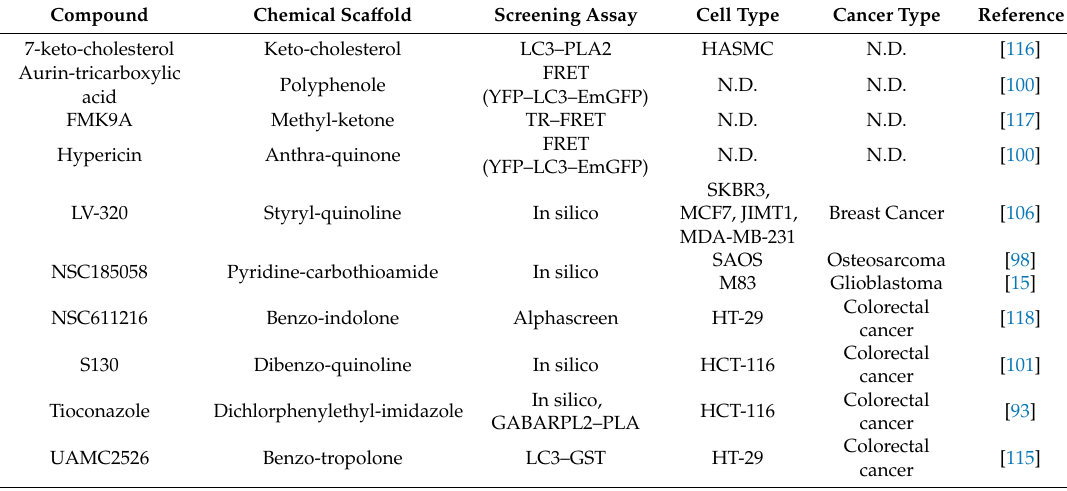
Table 2. ATG4B inhibitors and their e ff ect on cancer cell growth. N.D., not